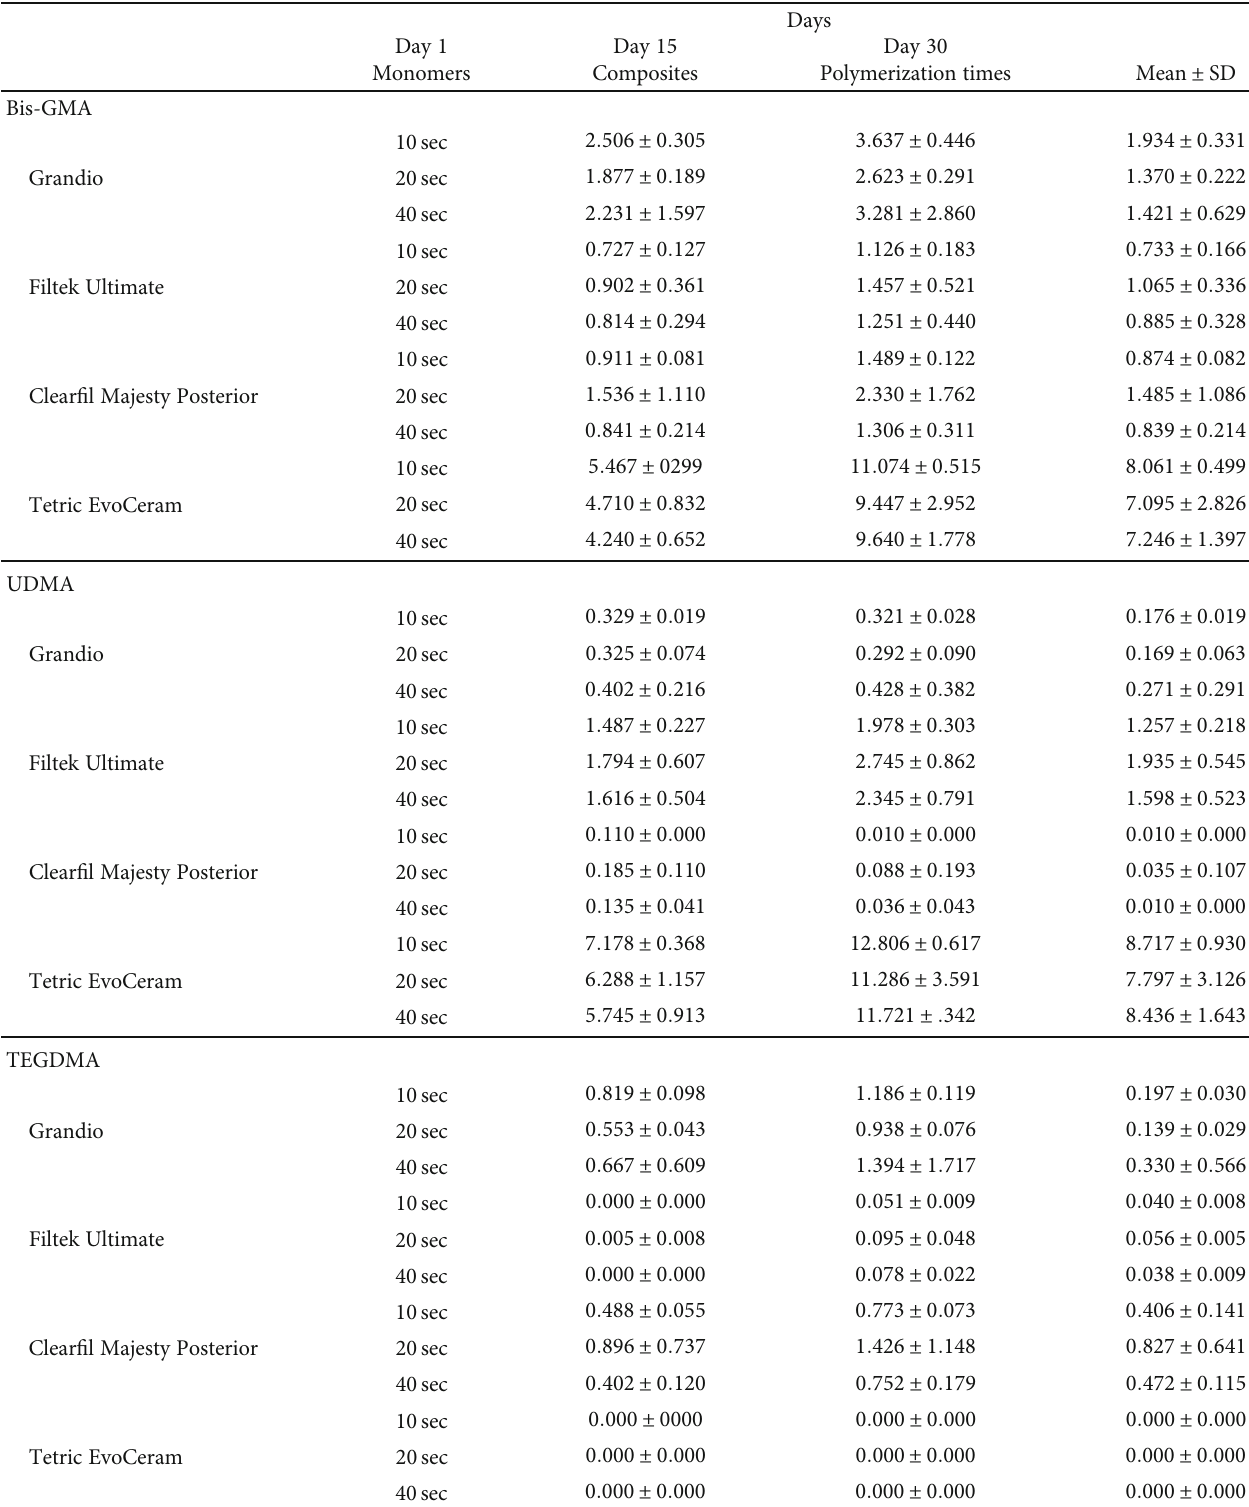
Table 2: Mean values (ppm) and standard deviations of the monomers